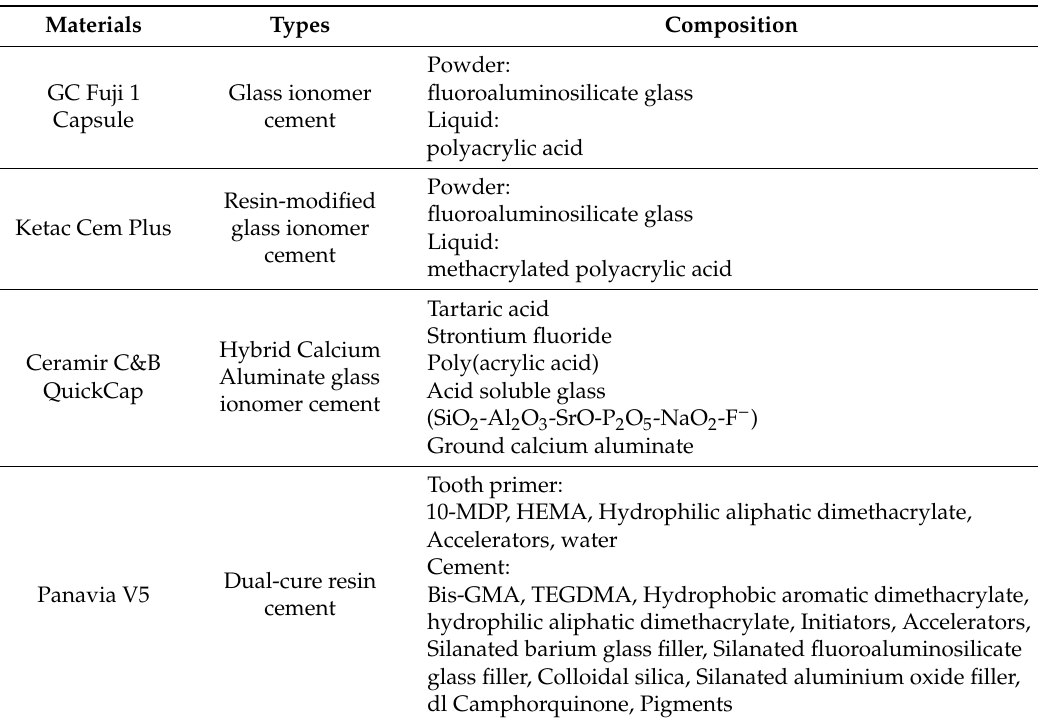
Table 1. Types and compositions of the cements used in the